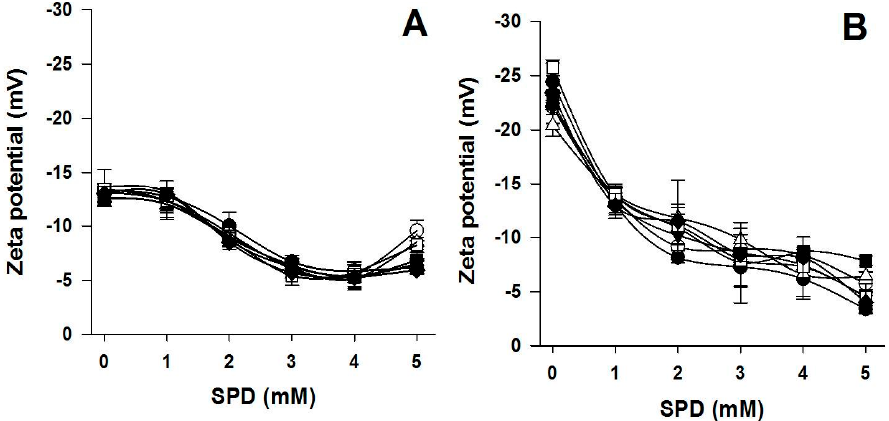
Figure 2. Effect of different SPD concentrations on 25 °C-treated ( A ) and 80 °C-treated ( B ) BVPC FFS zeta potential measured at pH 8.0 in the absence or presence of GLY. The different FFSs were prepared in the absence ( ) or presence of 4 ( ), 8 ( (cid:72) ), 17 ( (cid:52) ), 25 ( (cid:4) ), 33 ( (cid:3) ) and 42 mM ( (cid:7) ) GLY. The results are expressed as mean ± standard deviation. Further experimental details are given in the text.